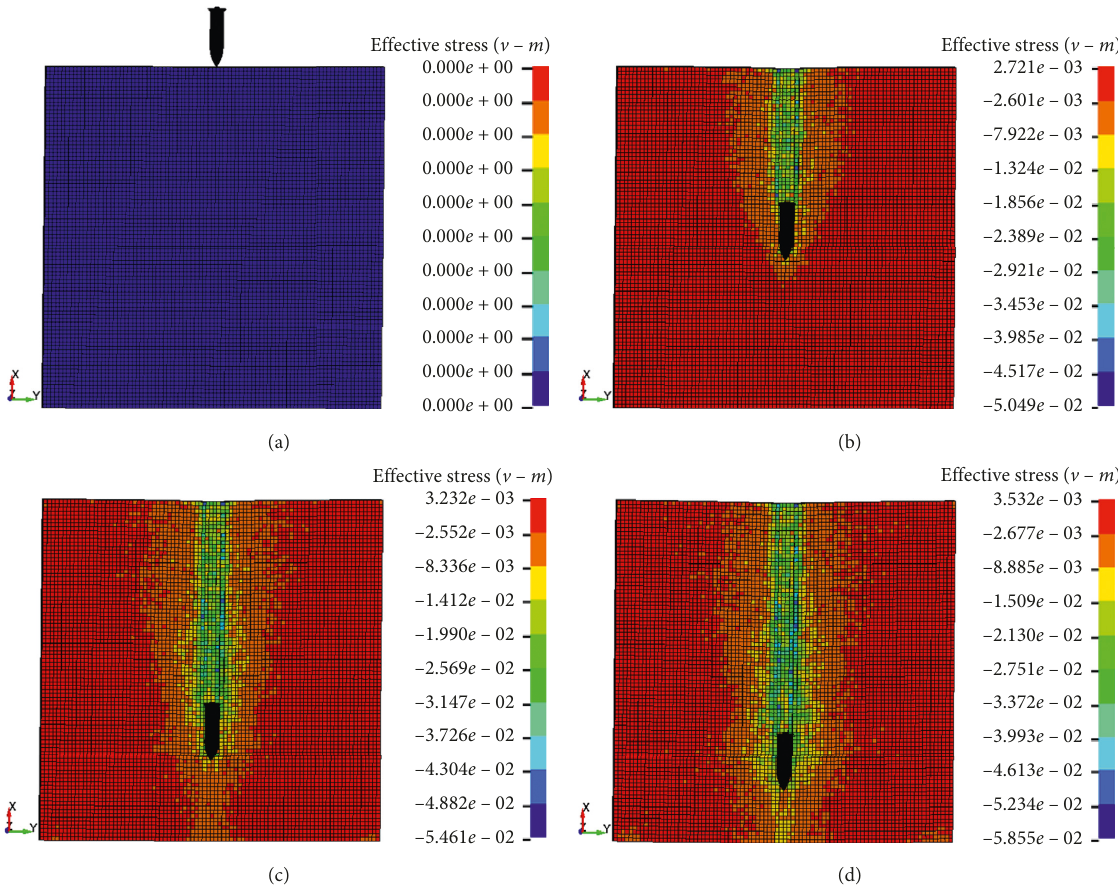
Figure 15: Motion trajectories at an initial speed of 150m/s. (a) t � 0s, (b) t � 0.02s, (c) t � 0.04s, and (d) t � 0.08s.